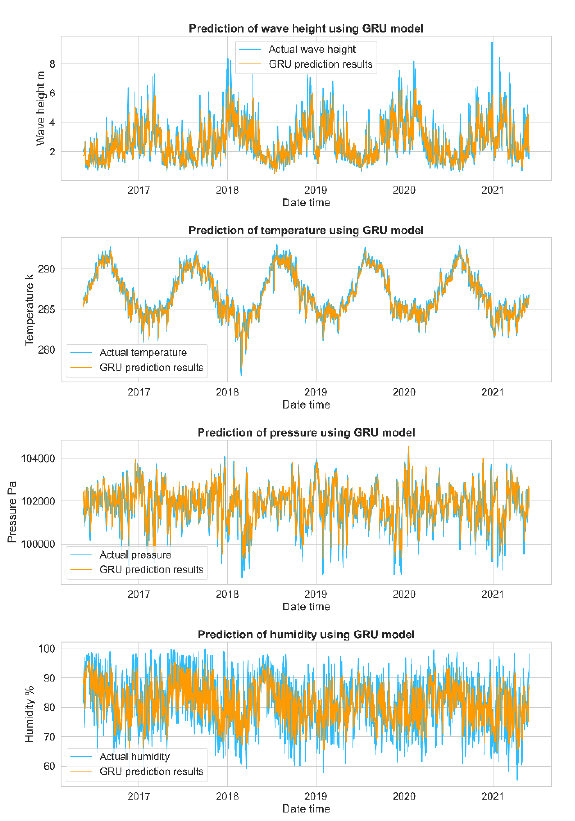
Figure 4 . Prediction of storm characteristics; wave height, temperature, pressure, and humidity using the GRU